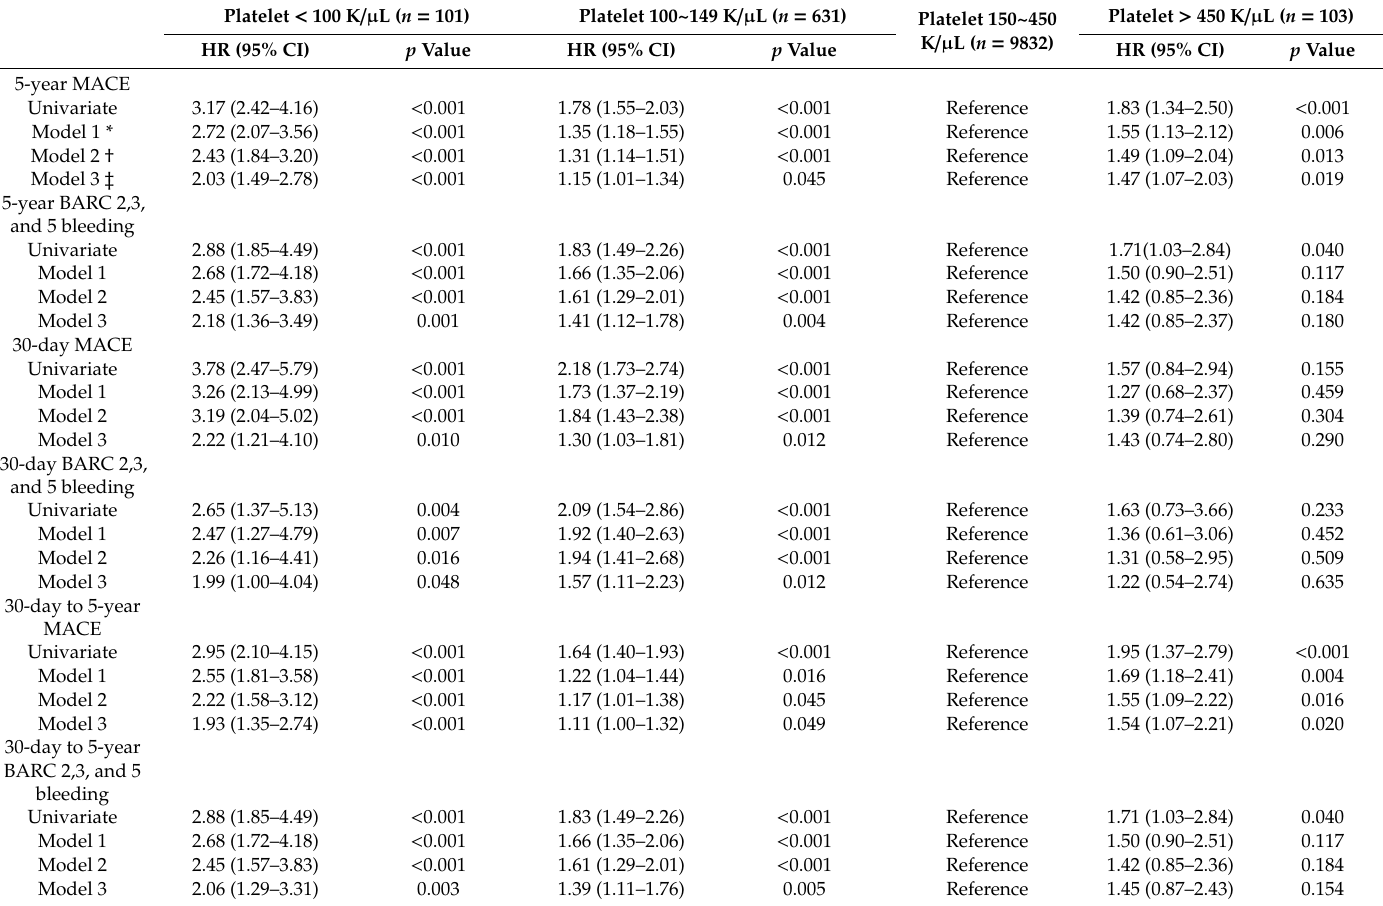
Table 3. Univariate and multivariate hazard ratios according to baseline platelet